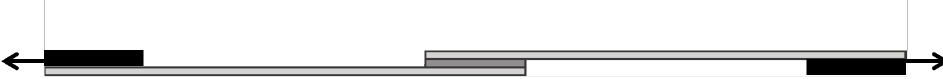
Figure 6. Single lap joints testing